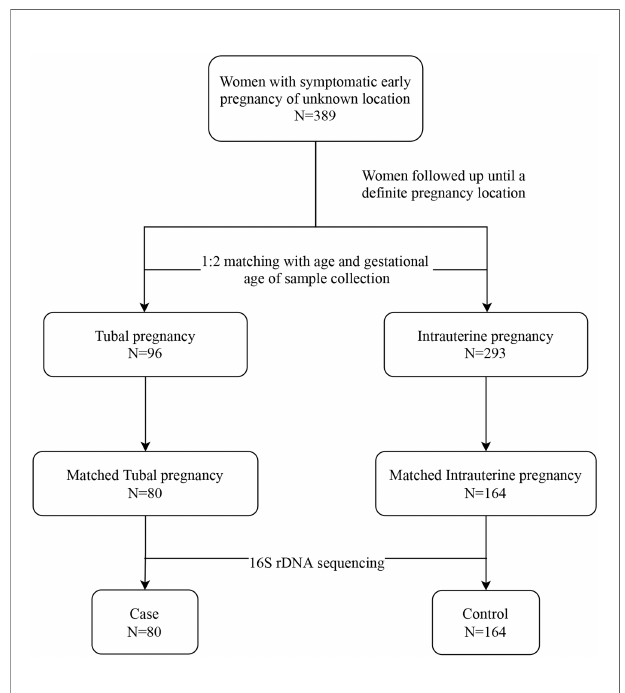
FIGURE 1 | The study fl